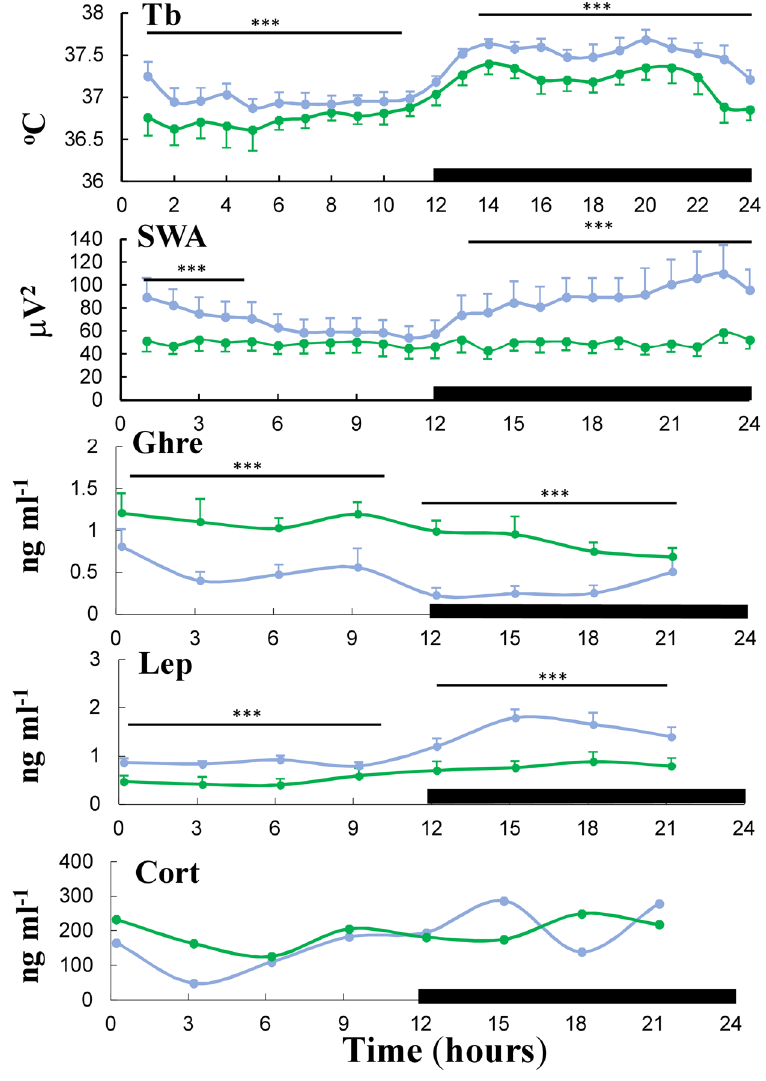
horizontal bars represent lights off (active period, 21:00–09:00) on a 12:12-h cycle. Error bars are s.e.m. *** p < 0.001 difference between control group (blue color) and obstructive group (green color). Differences between groups were determined by two-way ANOVA followed by Student-Newman-Keuls